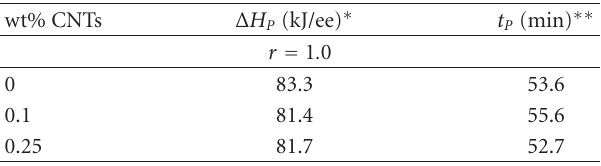
Table 2: Summary of the isothermal DSC results at 100 ◦